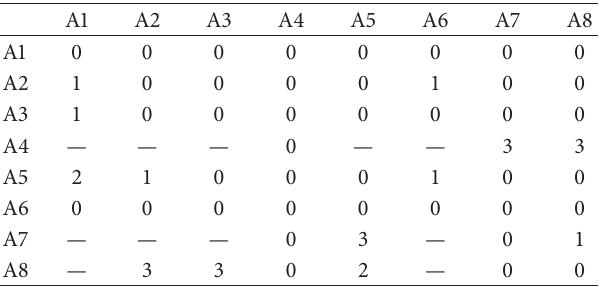
Table 1: Times of diluting remaining melt needed when alloy kind